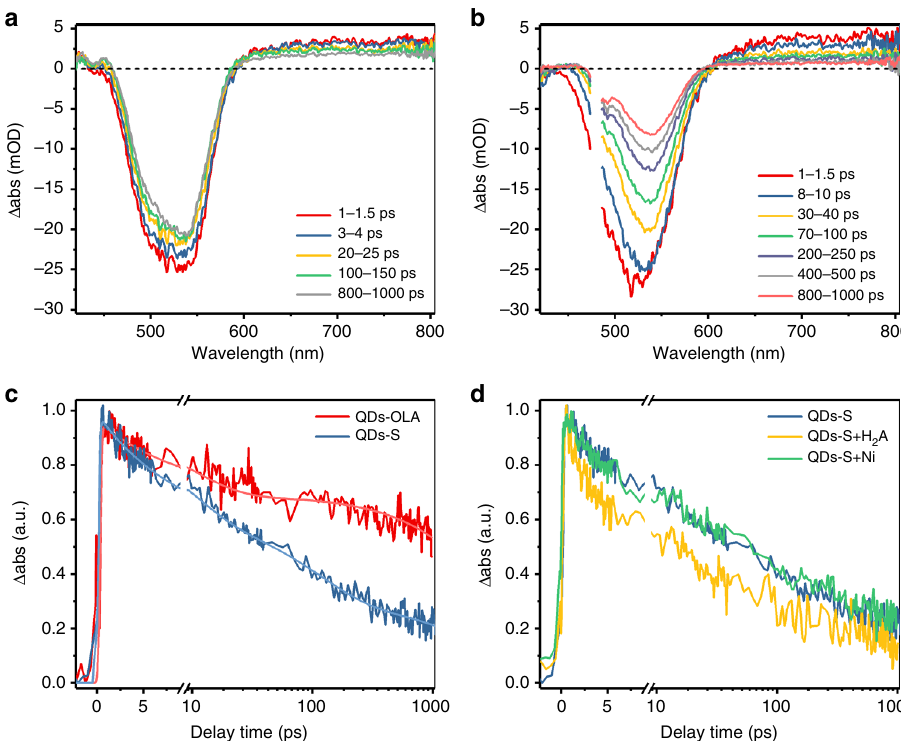
Fig. 3 fs-TA spectra of InP/ZnS QDs (525 nm, 15 min). a TA spectra of InP/ZnS-OLA QDs; b TA spectra of InP/ZnS-S QDs at indicated delay time windows. c TA kinetics at 725 nm (average from 700 nm to 750 nm) for the PA signal and the corresponding fi tting curve of InP/ZnS-OLA and InP/ZnS-S QDs. d TA kinetics at 725 nm (average from 700 nm to 750 nm) for the PA signal of InP/ZnS-S QDs with and without introduction of H 2 A or Ni 2 + into the solution. Conditions: pump pulses wavelength: 480